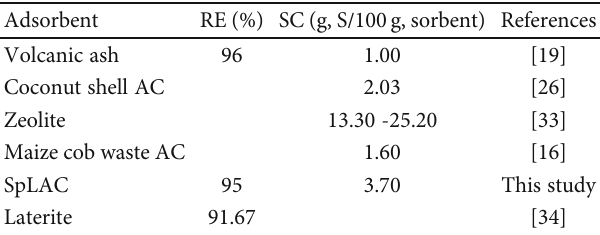
Figure 9: (a) H S concentration after sorption; (b) removal e ffi ciency and sorption capacity. Test conditions: T 2 m = 1 : 0g , KOH:C 1:1, C = 529ppm . 0 Table 6: Comparison of the SpLAC with other materials. Adsorbent RE (%) SC (g, S/100 g, sorbent)